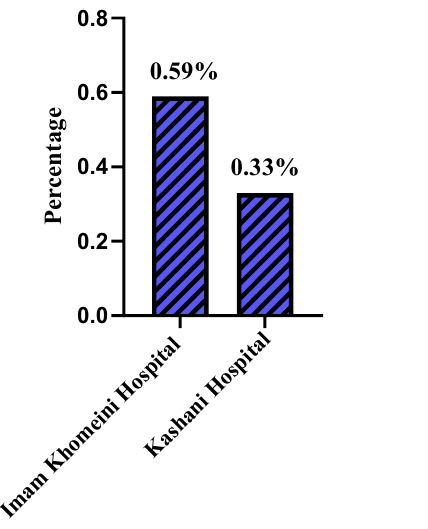
Figure 1. Frequency of Blood Transfusion Complications in Imam Khomeini and Kashani Hospitals.